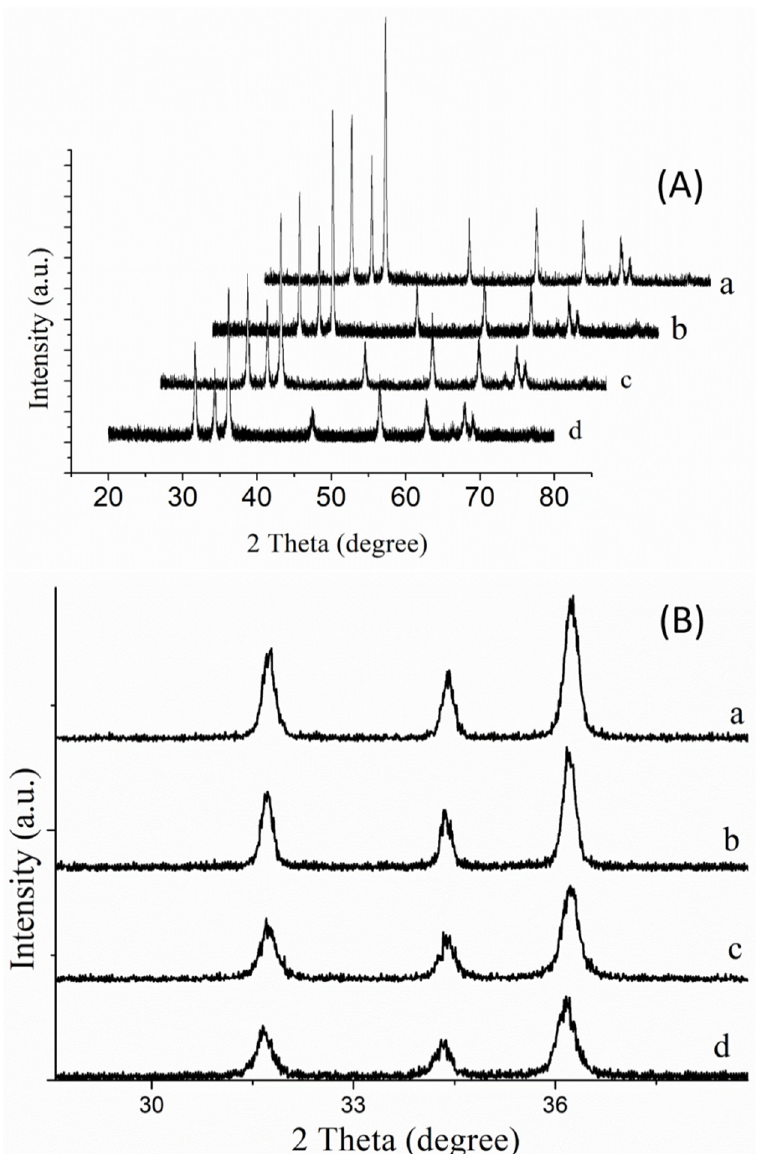
Figure 3. ( A ) XRD spectra of Au (0.0, 0.5, 1.0 and 1.5 wt %)-doped ZnO–Sm nanoparticle films. ( B ) Decrease in peak intensity.